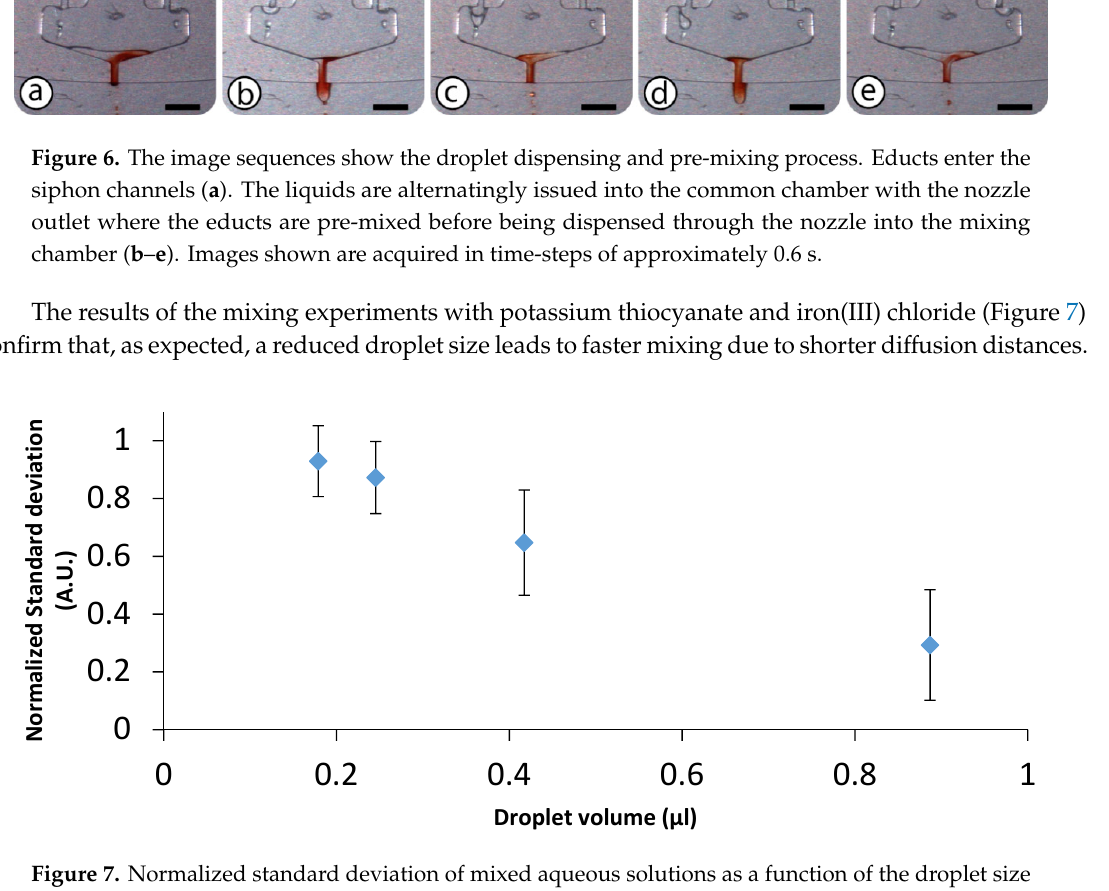
Figure 8. Results of mixing experiments with blood plasma and PBS buffer for two different mixing ratios. Histogram ( a ) shows the concentration distribution for a dilution of 1:5, while histogram ( b ) displays the distribution for a mixing ratio of 1:2.6. The red bars indicate the populations with the target dilution.